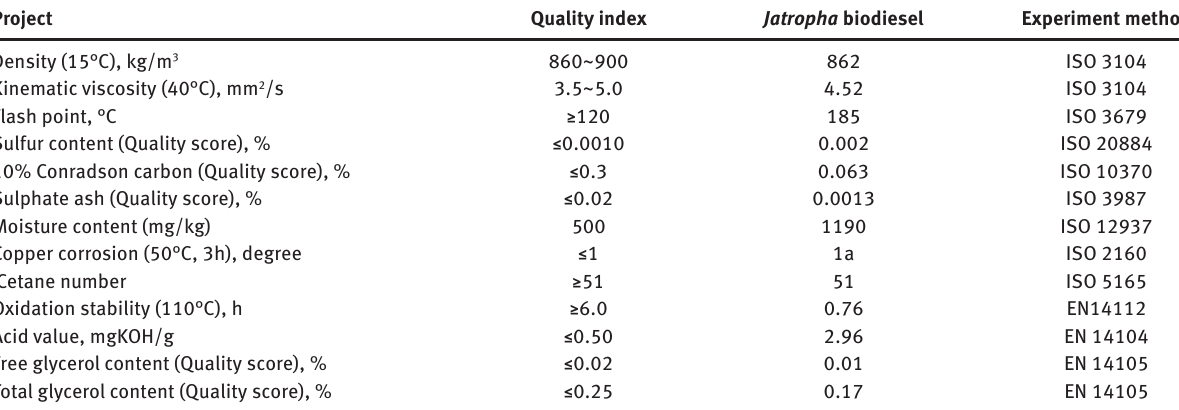
Table 1: European standard for biodiesel and physic-chemical performance index of Jatropha biodiesel. Project